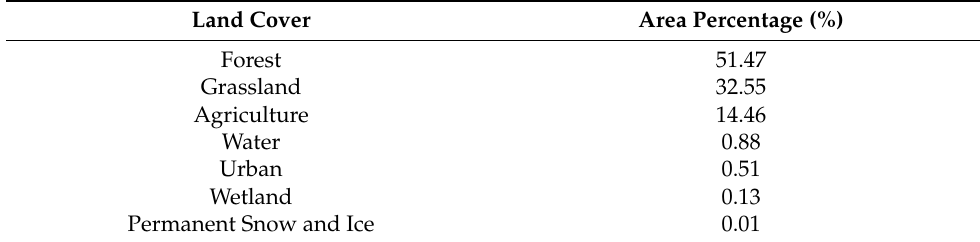
Figure 1. Geographical characteristics of the Amur River Basin ( a ) and its land cover distribution ( b ), modified from the MODIS MCD12Q1 product in 2010. Table 1. Primary land cover classes over the study